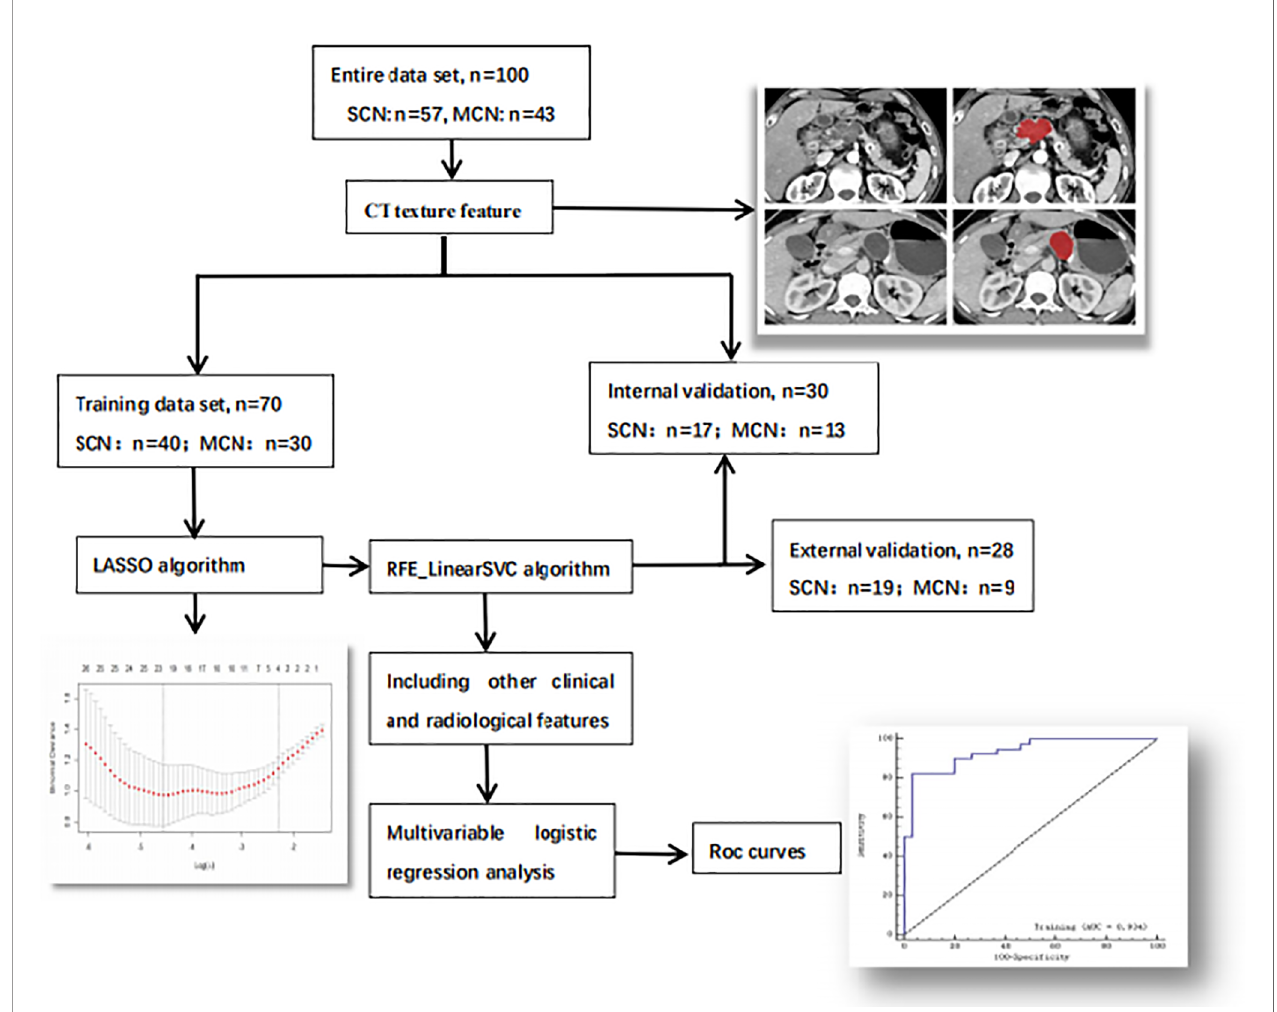
FIGURE 2 | Work fl ow of the research. The work fl ow can be divided into four parts: image acquisition, texture feature extraction, texture feature selection and model